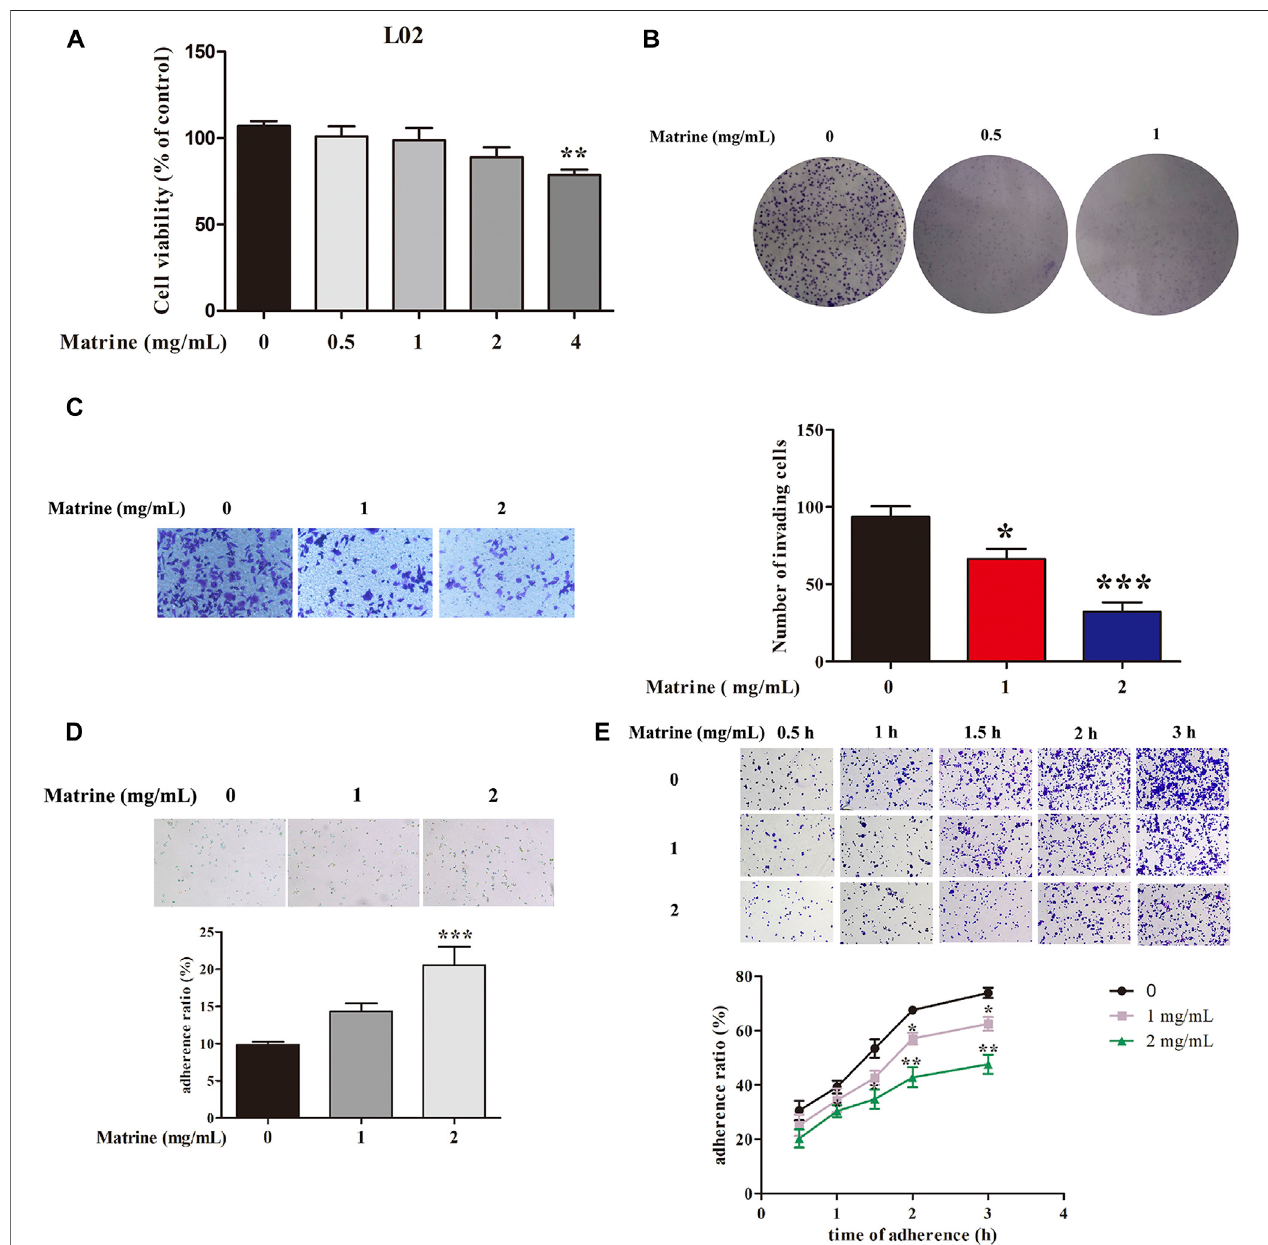
FIGURE 1 | (A) Effects of matrine on the proliferation of L02 cells. (B) inhibitory effects of matrine on the clone formation, (C) invasion, (D) cell – cell adhesion, and (E) cell matrix adhesion in SMMC-7721 cells. Data are represented as mean ± SEM ( n = 3). * p < 0.05, ** p < 0.01, *** p < 0.001 as compared with control group.